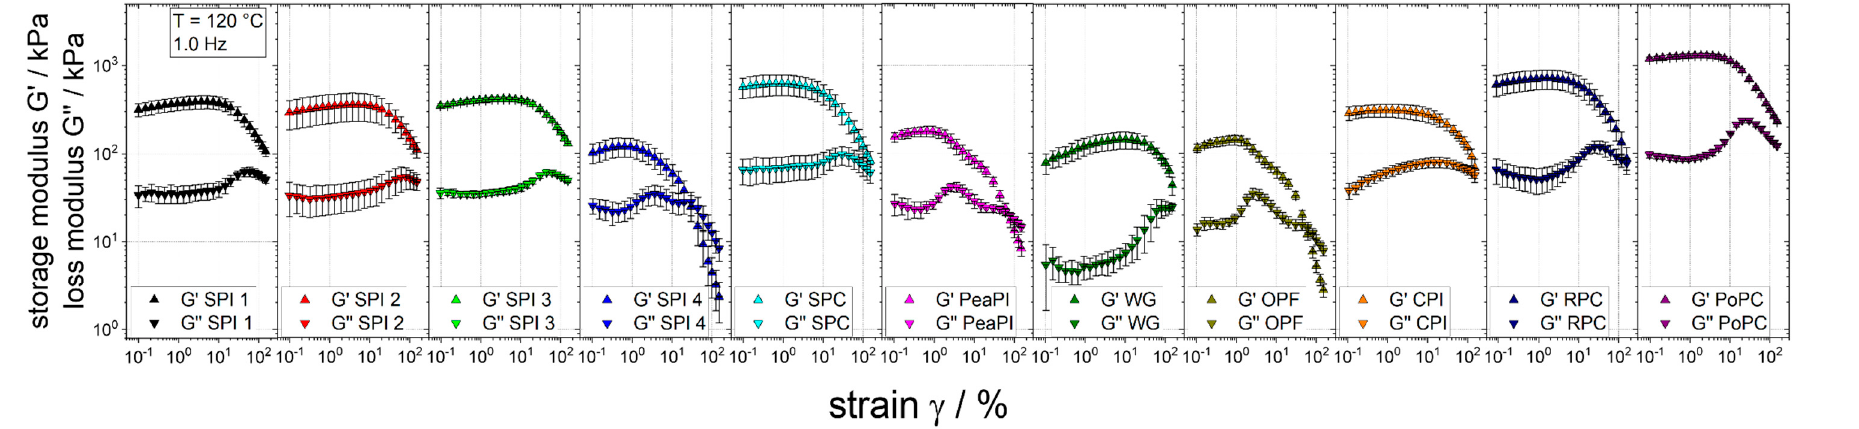
Figure 3. Strain sweeps at 120 °C and 1.0 Hz of different raw materials at a moisture content of 30%.